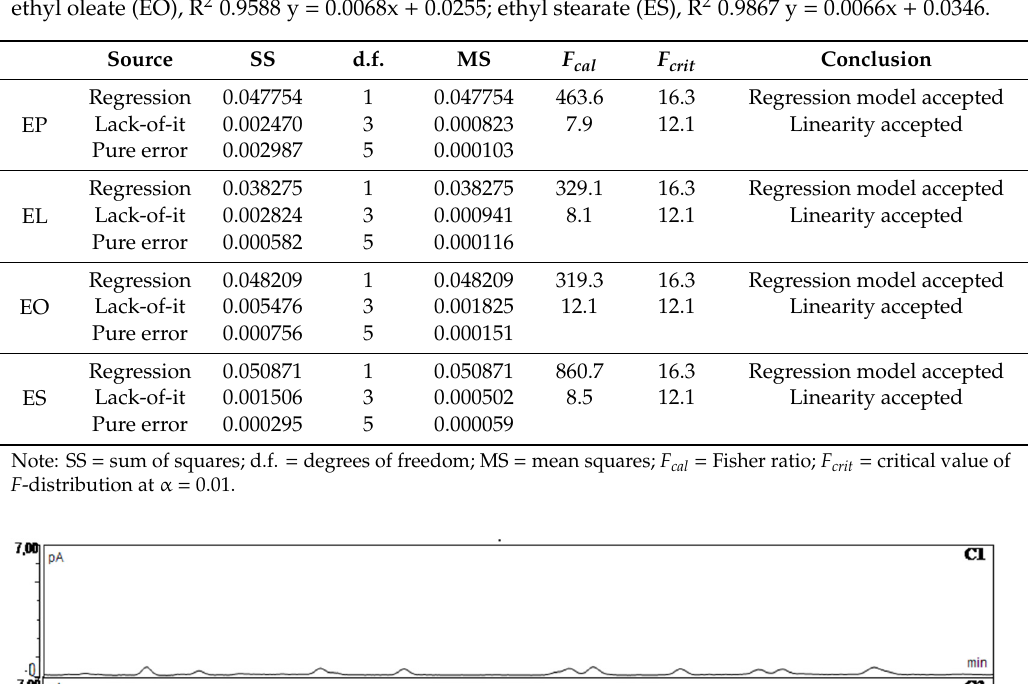
Table 2. Results of ANOVA statistics on significance test for regression model and linearity (lack-of-fit test) for all the four considered analytes. Linearity was examined considering the mixture of standards Table 1. Relative retention time (RRT) measured for the fatty acid ethyl esters considered in relation at 5 di ff erent concentrations (C1: 0.0025 mg / mL, C2: 0.005 mg / mL, C3: 0.010 mg / mL, C4: 0.025 mg / mL, to methyl heptadecanoate (used as internal standard). C5: 0.050 mg / mL). The R 2 values and the equations for calibration curves of the four compounds were: